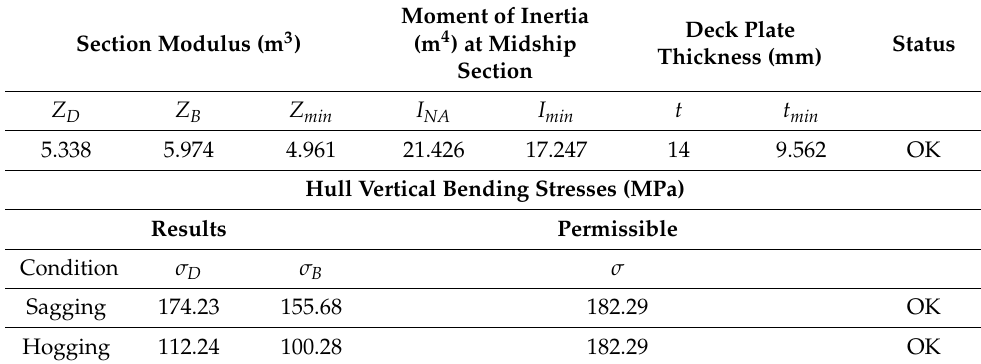
Table 5. Parameters of barge determined using Lloyd’s Register